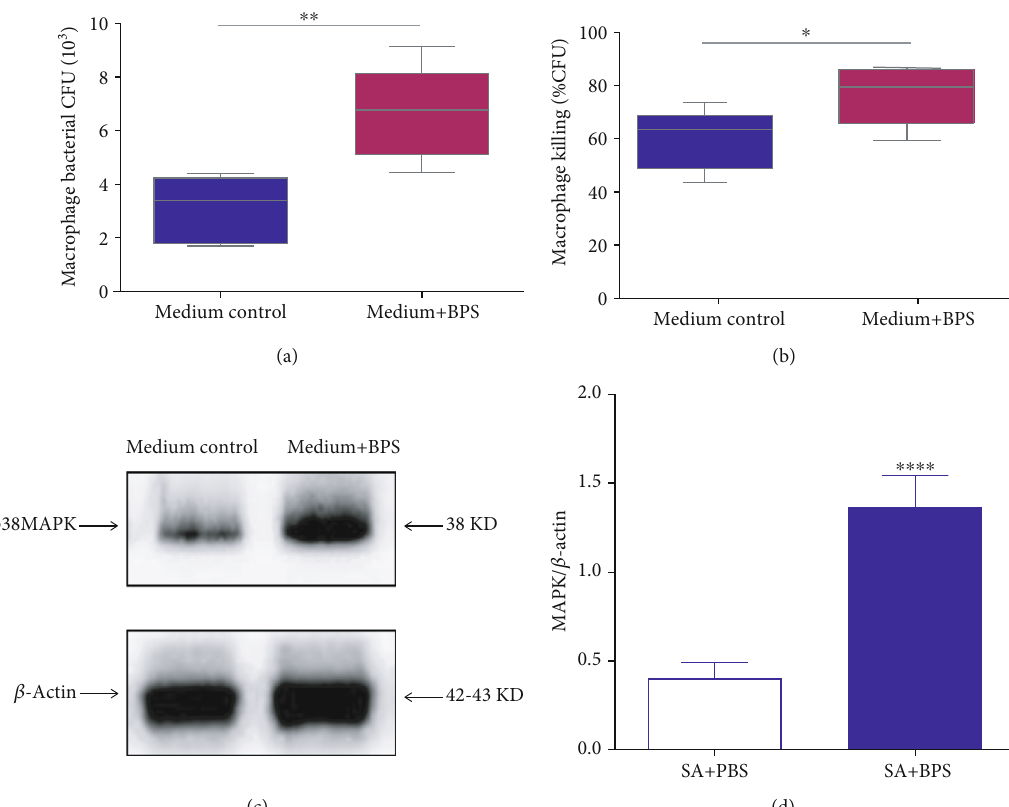
Figure 6: E ff ects of basil polysaccharide treatment on the ability of macrophages to eliminate and swallow bacteria. (a, b) 12 h BPS treatment was conducted on macrophages, followed by 30 min of S. aureus (MOI, 10) or FITC-labeled S. aureus infection under 37 ° C. We then determined the swallowed FITC-labeled S. aureus count and intracellular bacterial killing ( t = 2 h) according to speci fi c descriptions. (c, d) After 12 h of BPS treatment, Western blotting assay was conducted to determine p38MAPK signals within macrophages. ∗ p < 0 : 05 , ∗∗ p < 0 : 01 , and ∗∗∗∗ p < 0 : 0001 , upon one-way ANOVA as well as LSD multiple comparisons, in comparison with the BPS